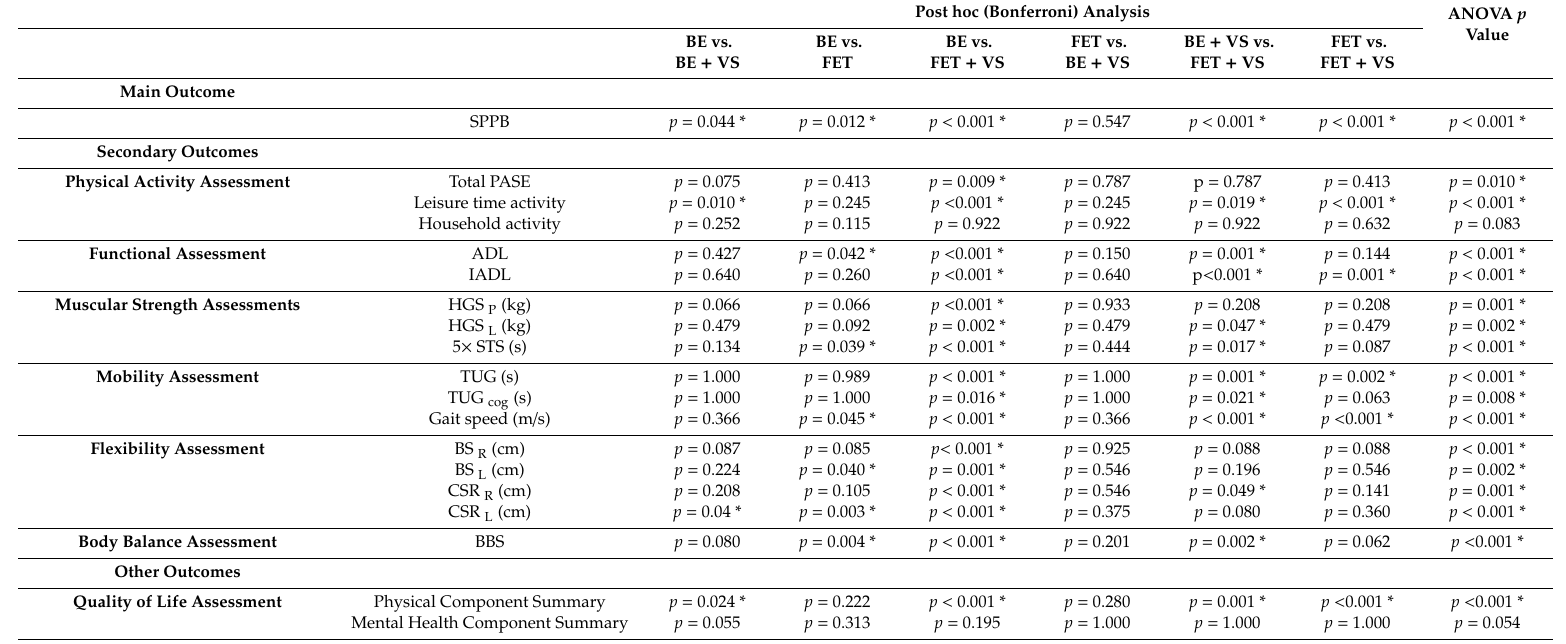
Table 4. Between-group comparisons at 24